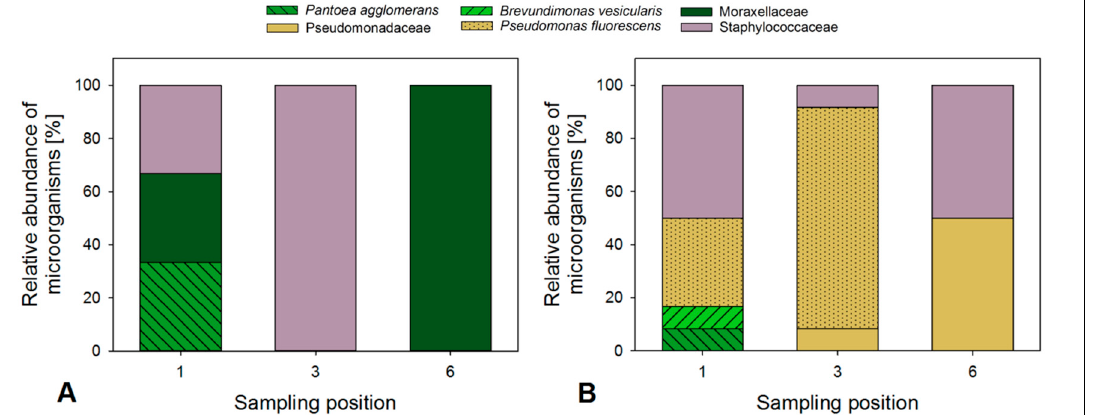
Figure 3. Culturable microbial community structure of endive lettuce (identified colonies only) along the washing process chain. The washing was conducted with the addition of PTW in the pre-rinsing step (10 s) (trial B) and the samples were analyzed after washing ( A ) and after storage for seven days at 2 °C ( B ). Sampling positions: (1) endive raw material; (3) endive after pre-rinsing; (6) endive after final rinsing.